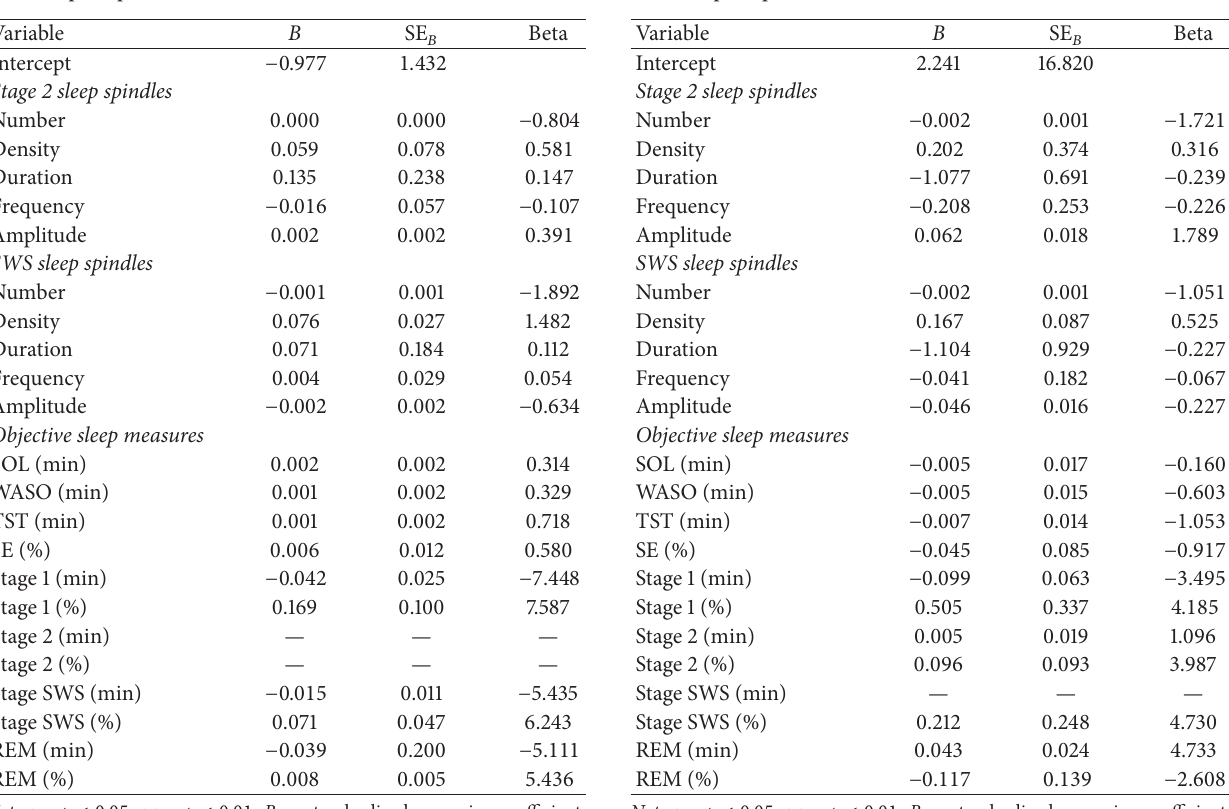
Table 5: Summary of multiple regression analysis for overestima- tion (Misperception Index < 0).